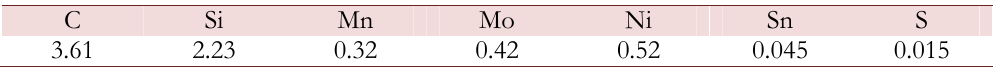
Table 4: Austempered DCI chemical composition GGG 70BA, Fig.